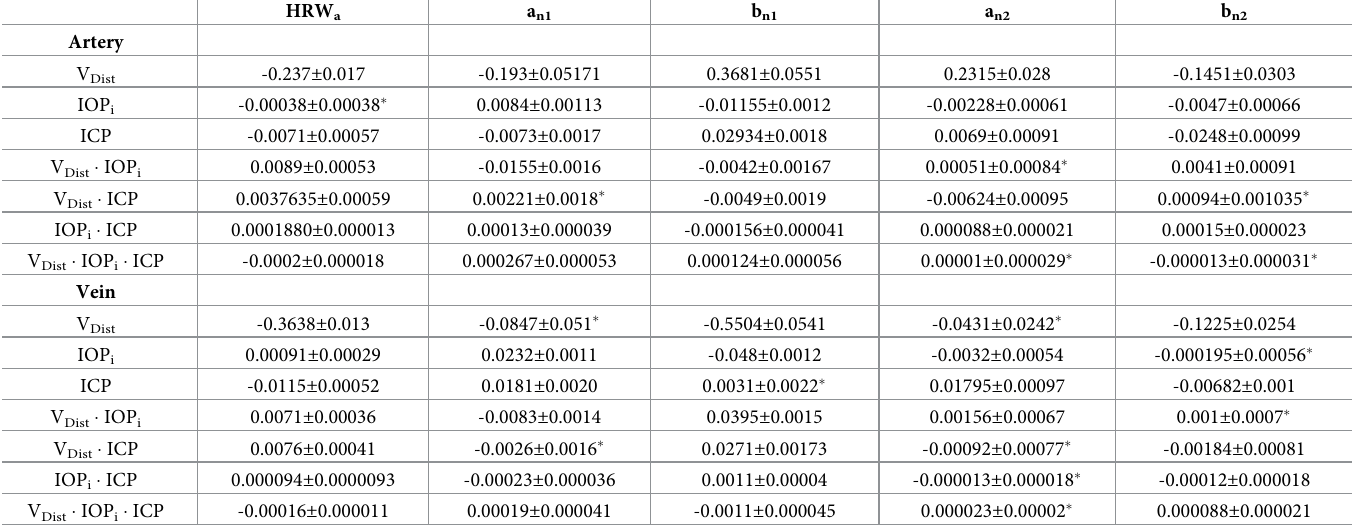
Table 3. Estimated interaction model coefficients.